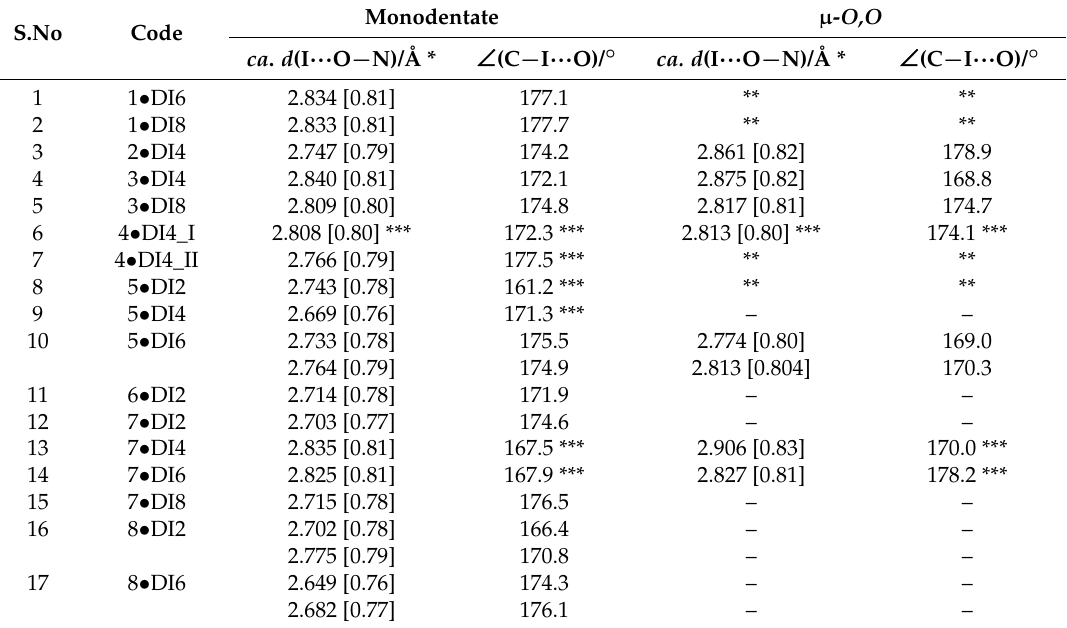
2.682 [0.77] 176.1 – – equivalent. *** Major disorder component.